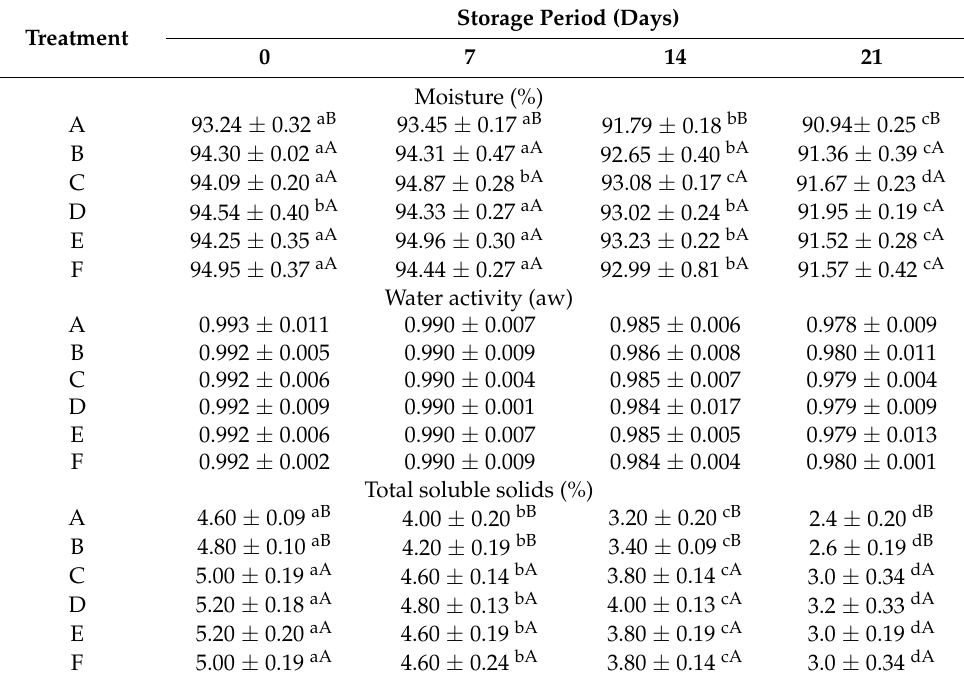
Table 1. Changes in water activity, moisture, and total soluble solids of fresh cucumber coated with chitosan and/or olive cake extract (OCE) or orange peel extract (OPE) during cold storage (4 ◦ C).